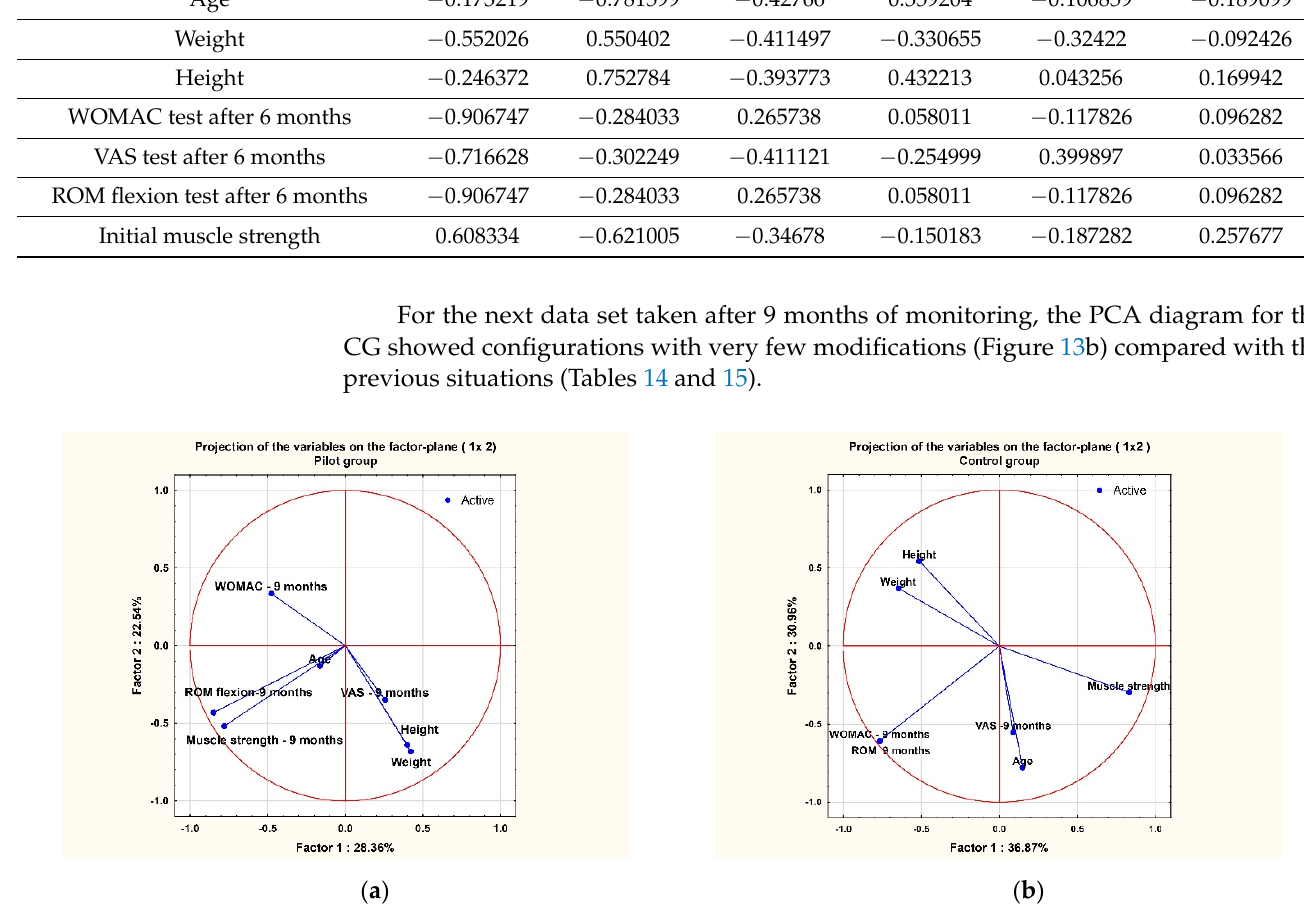
Table 13. Factor coordinates of the variables based on correlations for the control group (CG) after 6 months.